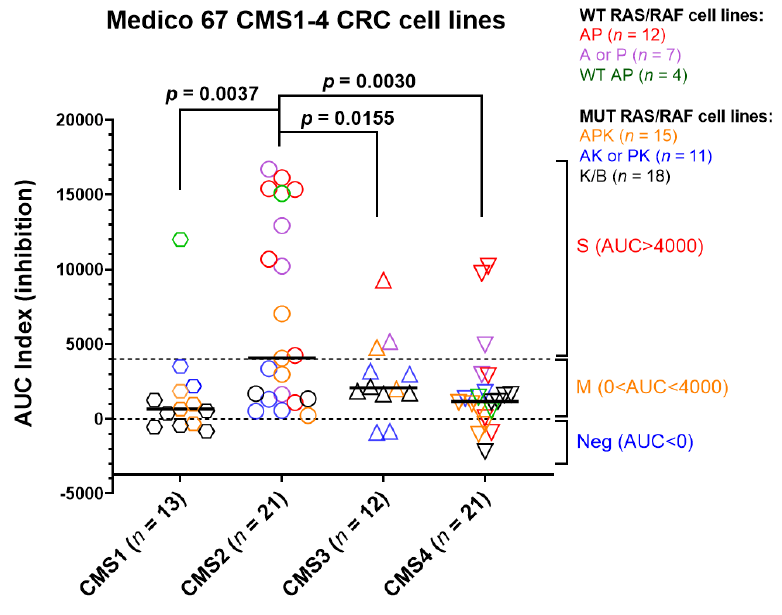
Figure 11. Comparison of CTX ‐ S scores among four CMS classes in Medico CRC cell lines. Bars represent median with interquartile range. p values are for two ‐ tailed Welch t test. Note that among 147 Medico cell lines treated with cetuximab, 67 cell lines are CMS1 ‐ 4 classes with the mutation data of APC, TP53, KRAS, NRAS, and BRAF . The six MUT vs. WT A/P/K/N/B subgroups are highlighted by colors.